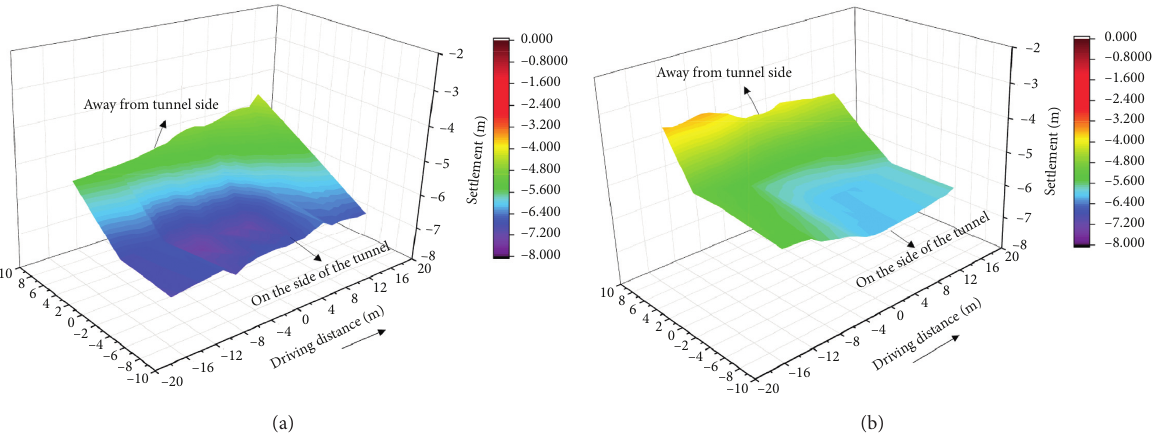
Figure 4: Three-dimensional deformation of foundation pit bottom. (a) Foundation pit No. 1. (b) Foundation pit No.